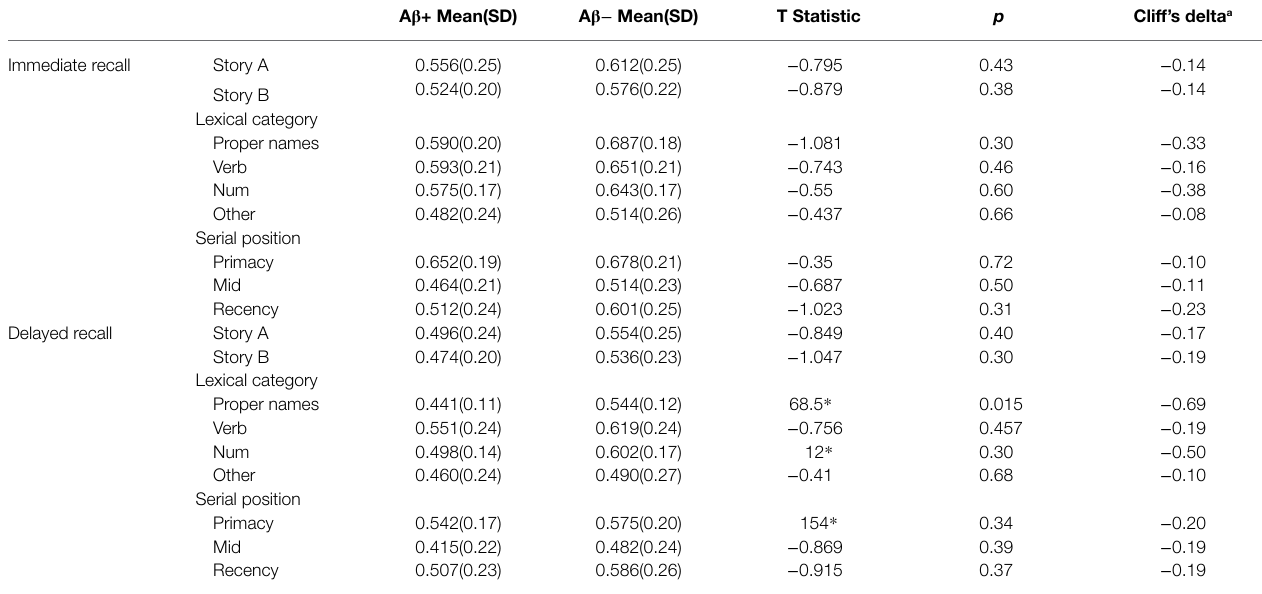
TABLE 4 | The difficulty indices difference between A β + and A β− group for immediate recall and delayed recall by story, lexical category, and serial